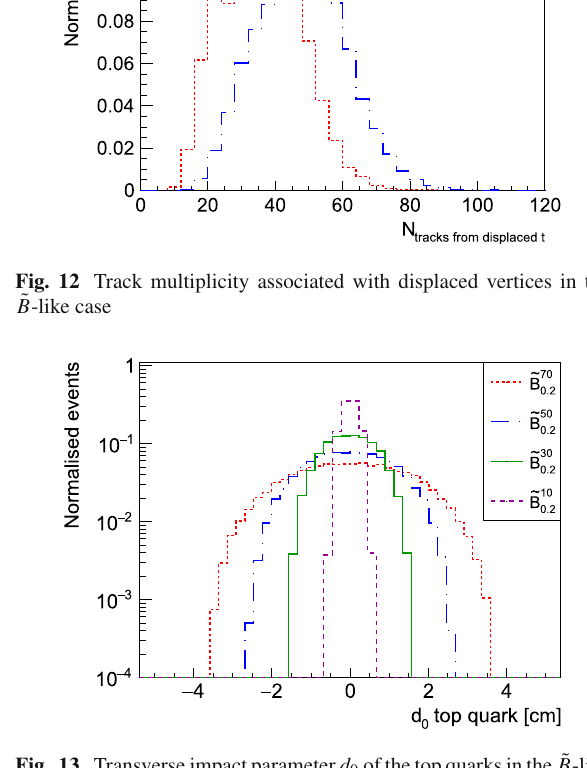
Fig. 10 Transverse momentum p T of the leading jet of the event in the ˜ B -like case